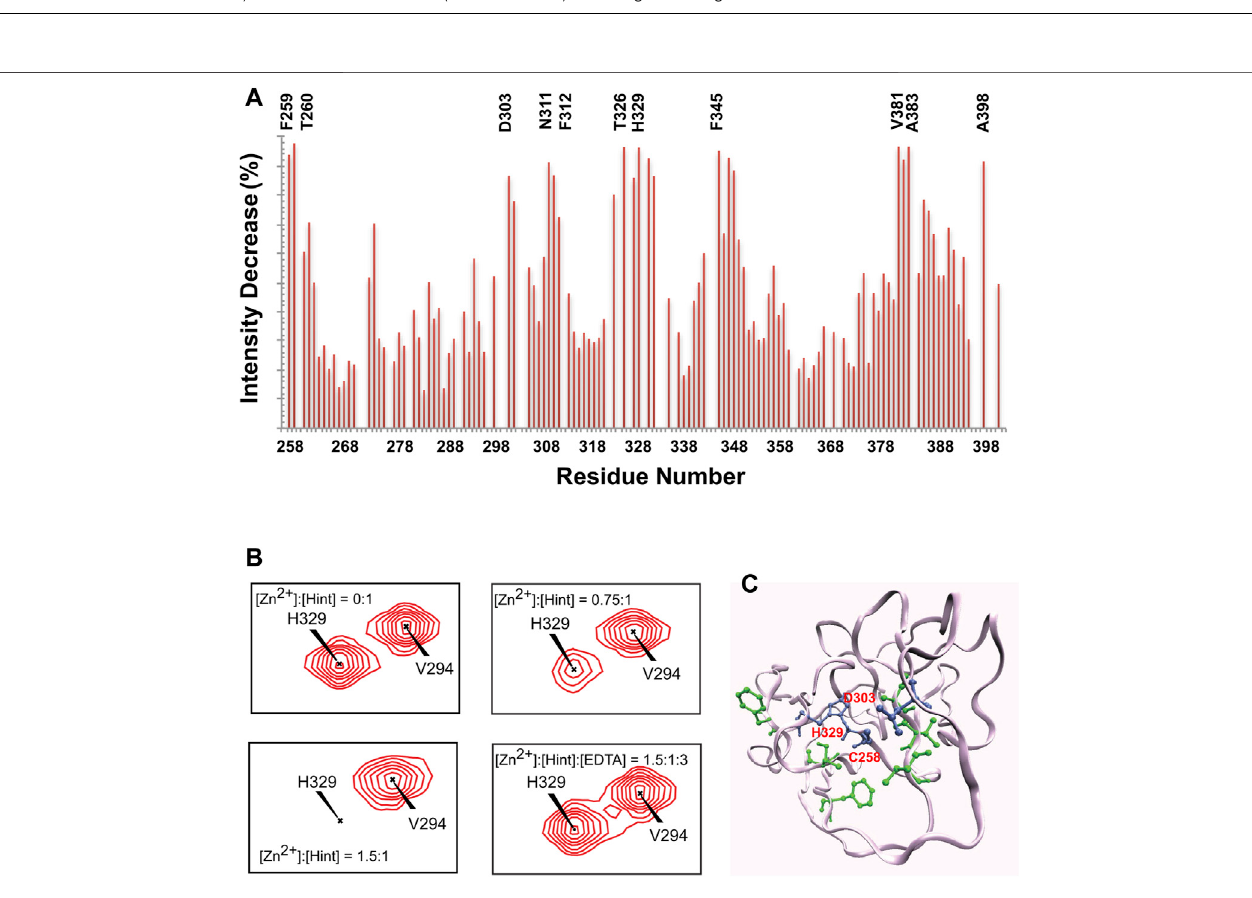
FIGURE 3 | Structural basis of zinc-Hint binding. (A) 1 H- 15 N HSQC signal intensity changes of Zn 2+ binding to Hint ([Zn 2+ ]:[Hint] = 1.5:1) at 25 ° C, residues with biggest changes labeled. (B) Chemical shift perturbation analysis for H329 backbone in 15 N-labeled Hint caused by zinc binding. The amide peak intensities of H329 decreasedwithincreasingzincconcentration.Missingsignalswererestored withadditionof2molarequivalentofEDTA. (C) StructuralmodelofHintbindingsiteofZn 2+ mapped onto the x-ray structure (PDB: 1AT0) based on the NMR signal intensity change. Blue residues indicate direct coordination sites, with the biggest signal decrease while green residues, with less signal reduction, likely play secondary role in zinc binding. Figure from the reference, Xie et al. (Xie et al., 2015) with permission.